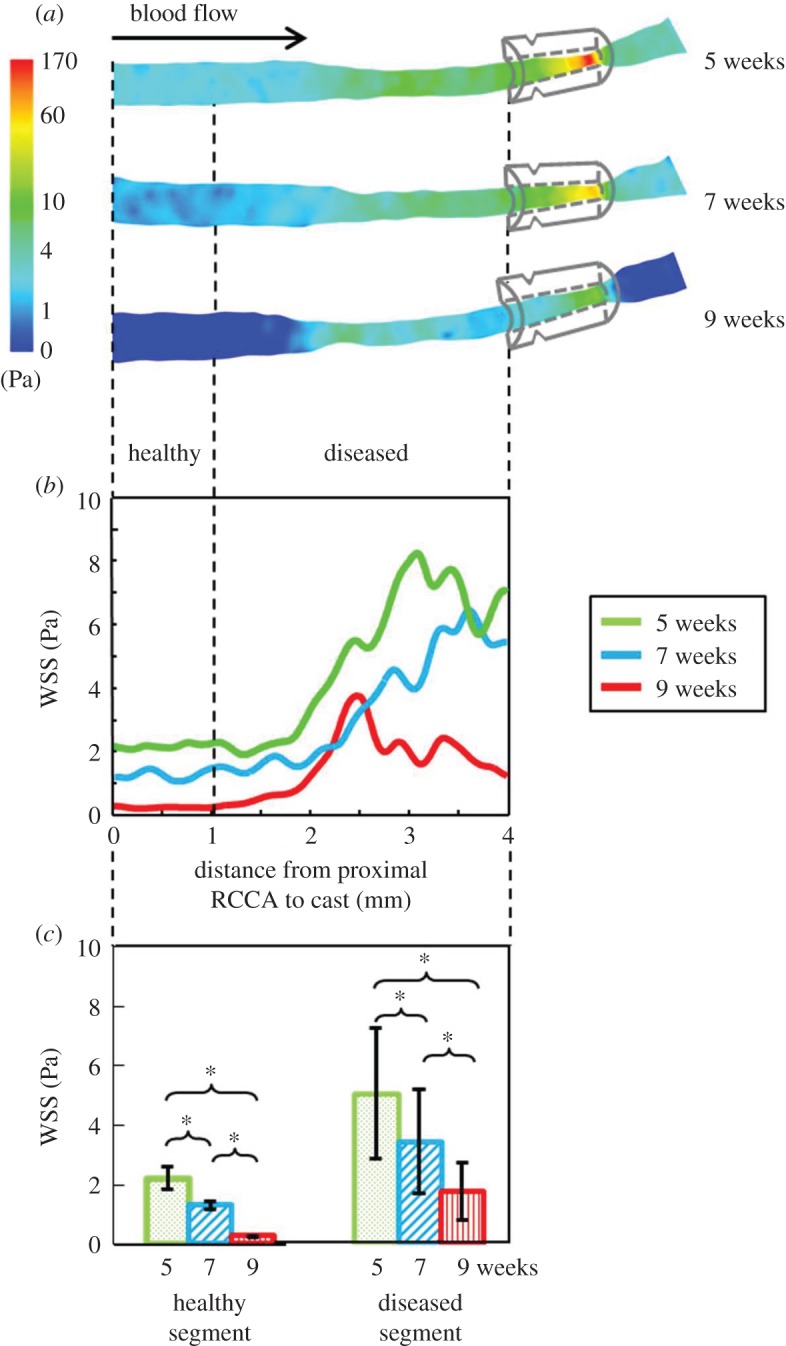
Illustration and quantification of WSS in a RCCA. (a) Three-dimensional WSS distribution in the RCCA of representative mouse 1 at 5, 7 and 9 weeks after cast placement. Circumferentially averaged WSS along the RCCA is shown (b). Proximally the RCCA was divided into a healthy and diseased segment, indicated by the vertical dashed line, based on the week 9 histology data. WSS distribution was heterogeneous over the diseased segment. Averaged WSS in both segments significantly decreased over time and was relatively higher in the diseased segment (Student's t-test, *p < 0.05).